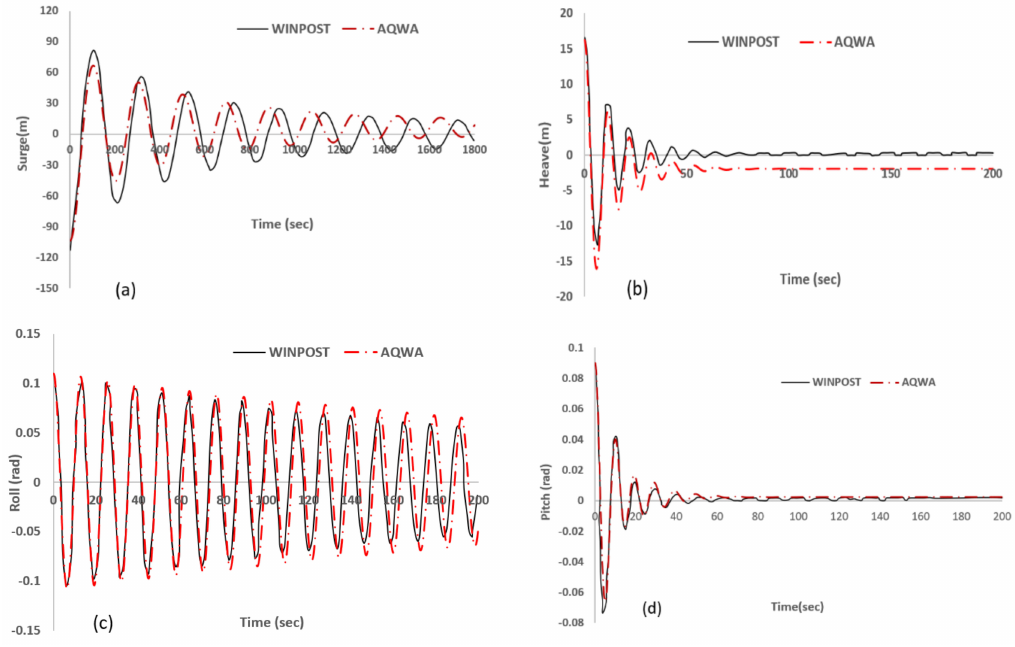
Figure 7. Comparison of free decay timeseries for ( a ) surge, ( b ) heave, ( c ) roll, and ( d )